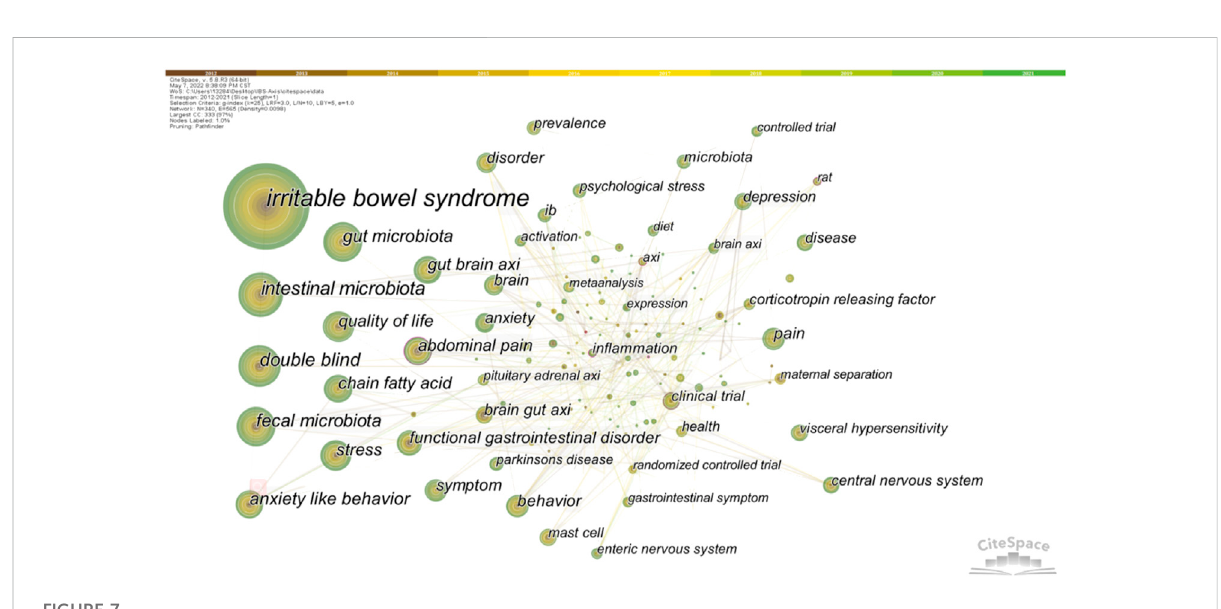
FIGURE 7 Co-occurring keywords